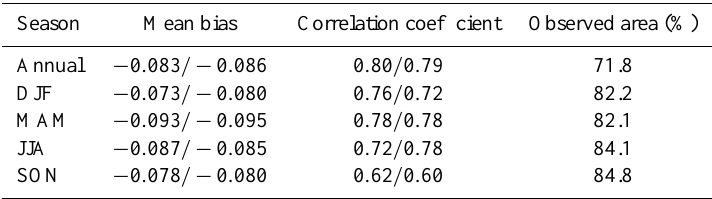
Table A7. Mean biases and linear correlation coefficients between the time averaged AOD fields from the simulations and the MODIS Level-3 product coarsened to the same resolution and averaged over the years 2000–2009. Grid areas where, for all consecutive years, the MODIS data are missing for one or more months during the year or season of interest have not been included in the calculations. The results for the EC-Earth and ERA-Interim simulations are separated by a